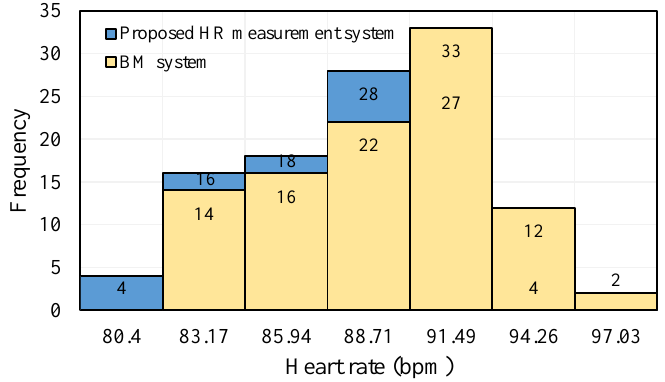
Figure 11. Histogram of the WHR data and BM device.